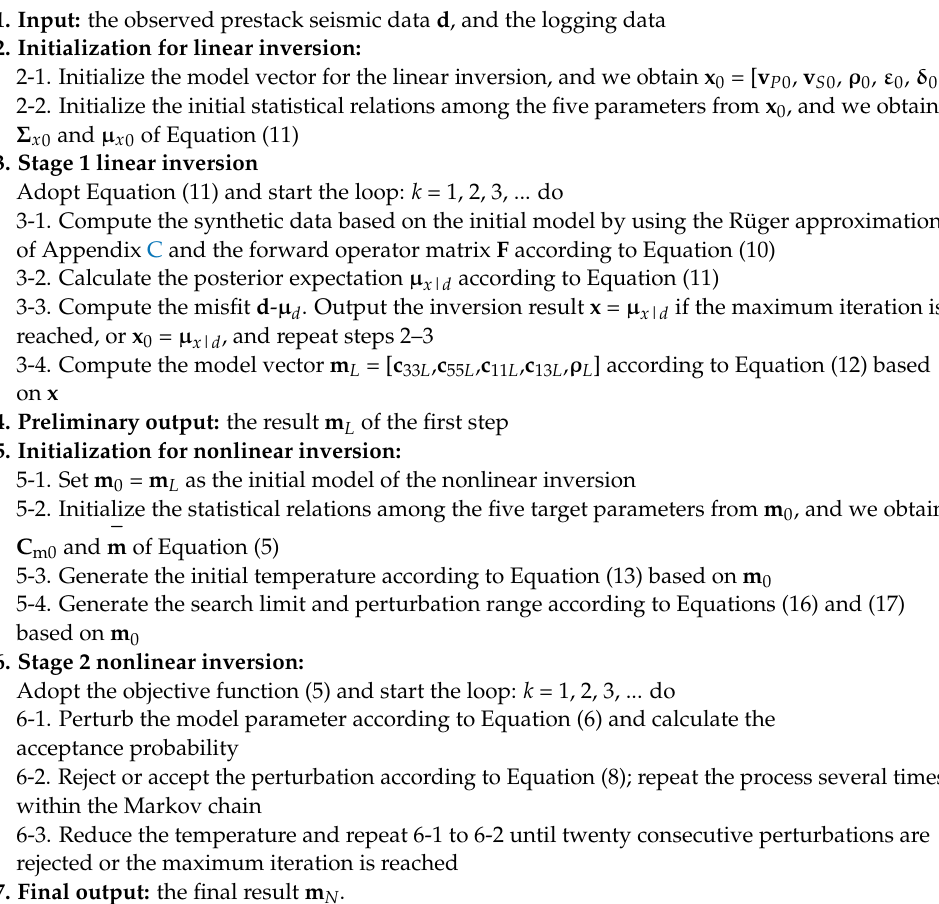
Algorithm 1 The Proposed Sequential Prestack Anisotropic Inversion